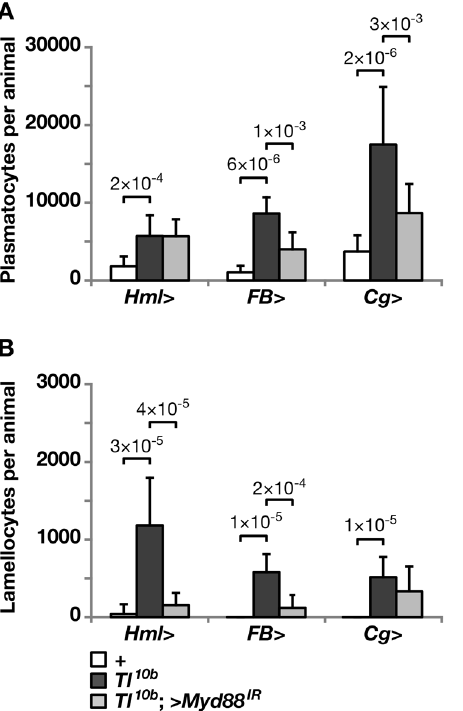
Figure 4. Toll-dependent hemocyte proliferation requires Toll signaling in fat body but not in hemocytes; Lamellocyte formation depends on Toll signaling in both tissues. A . The number of plasmatocytes is increased in the hemolymph of larvae carrying the Toll gain-of-function mutant Toll 10b . This phenotype is not affected when Toll signaling is suppressed by the UAS-MyD88 GD25399 construct ( . MyD88 IR ) with a hemocyte driver ( Hml . ), but it is partially reversed with fat body (FB . ) or hemocytes plus fat body ( Cg . ) drivers. B . Circulating lamellocytes are found in Toll 10b larvae. This phenotype is partially reversed when Toll signaling is suppressed by Myd88 RNAi in hemocytes ( Hml . ), fat body ( FB . ) or in both hemocytes and fat body ( Cg . ). Plasmatocytes and lamellocytes were distinguished by morphol- ogy and counted separately. The results are presented as the means + / 2 standard deviation from three independent experiments with ten individual larvae in each cross, and the significance levels were estimated by independent sample T-test (two-tailed) in A and Mann- Whitney U exact test (two-tailed) in B.